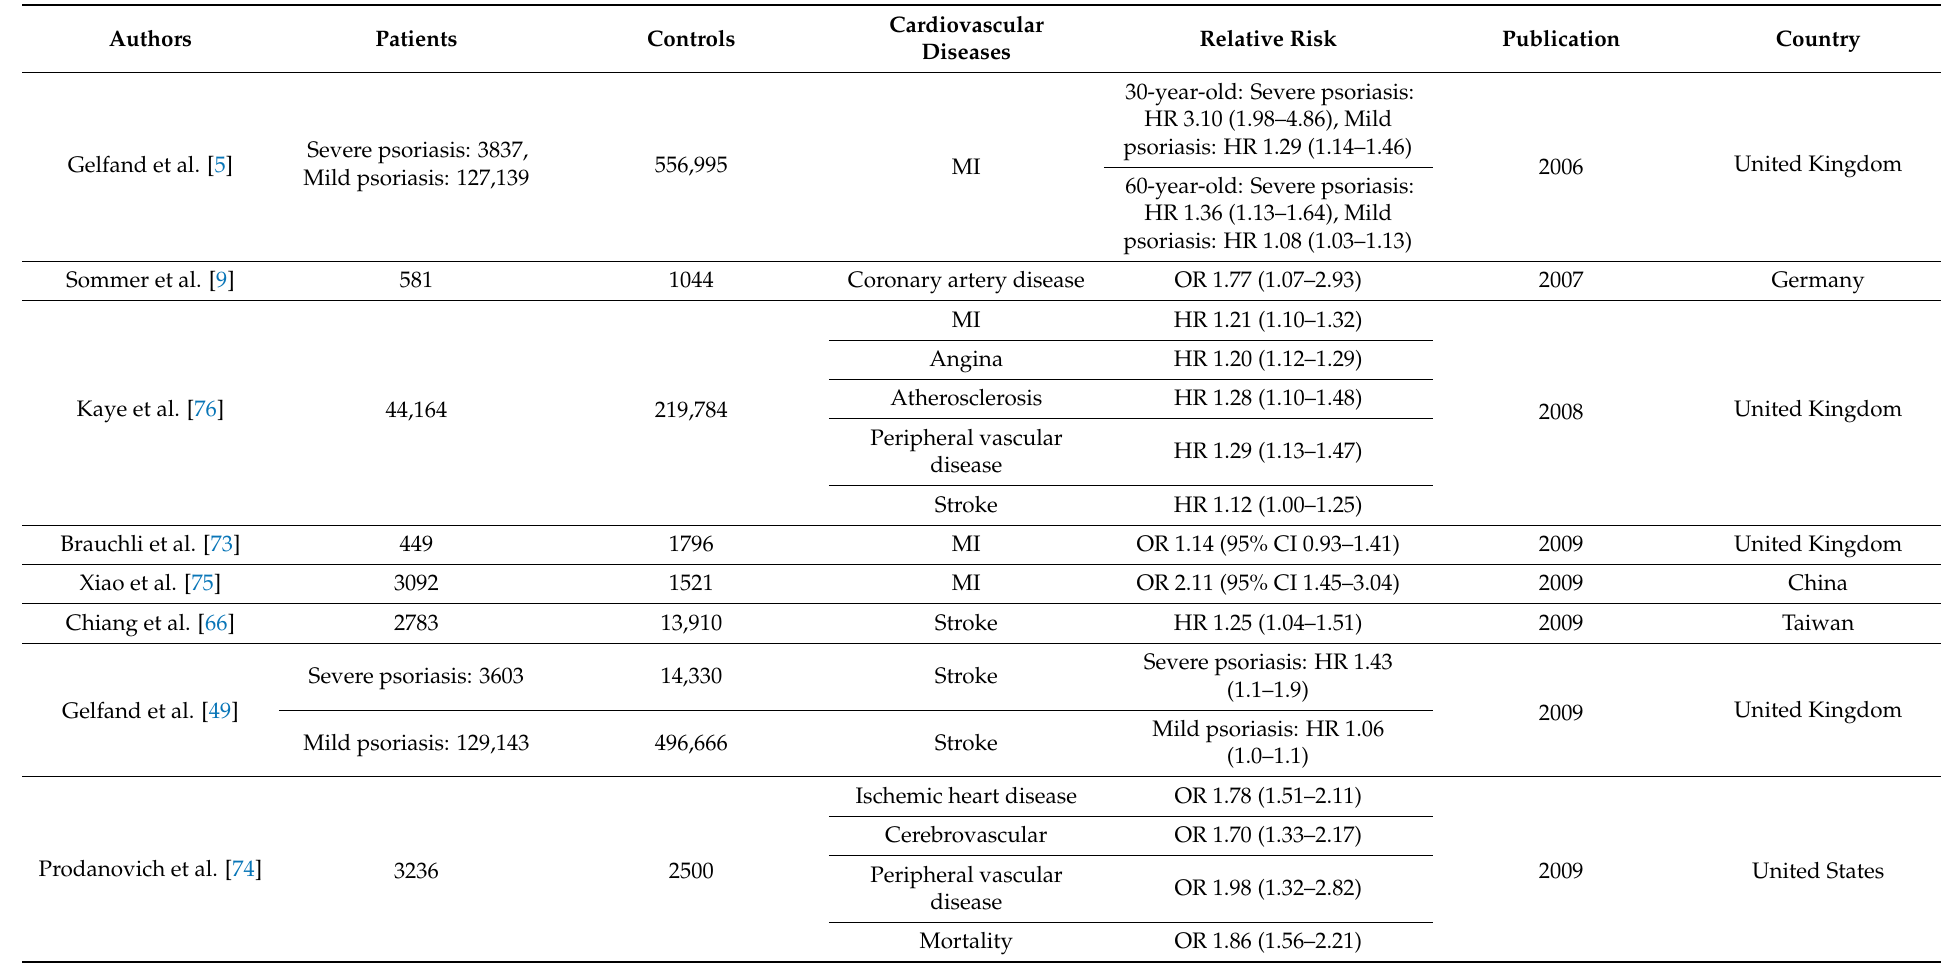
Table 1. Summary of studies investigating the relationship between psoriasis and cardiovascular diseases. Hazard ratios (HRs) or odds ratios (ORs) with 95% confidence